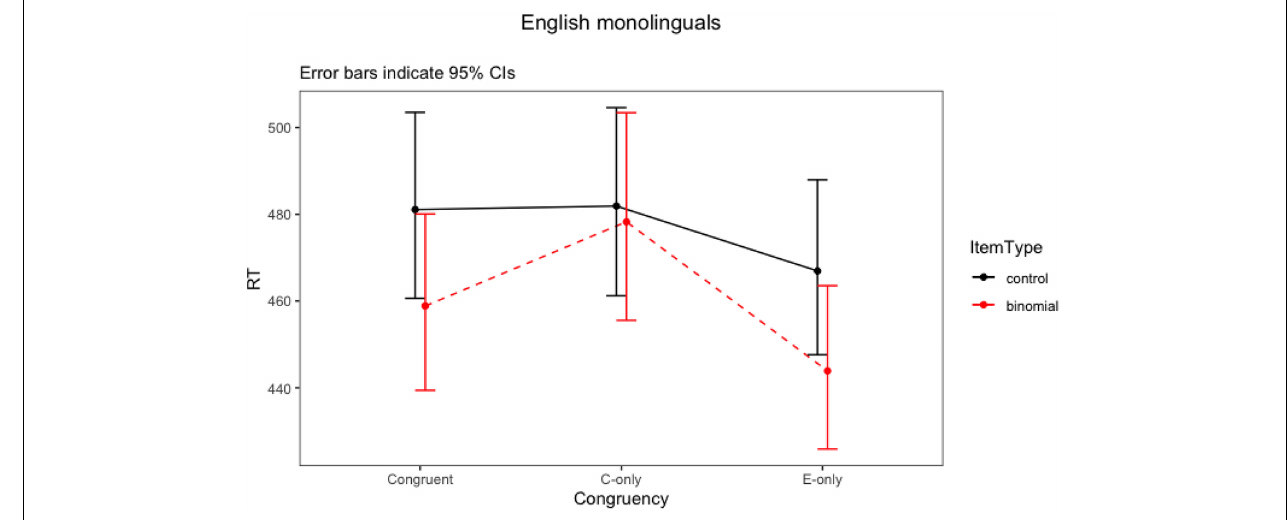
FIGURE 1 | Interaction plot of Item type * Congruency for English monolinguals.